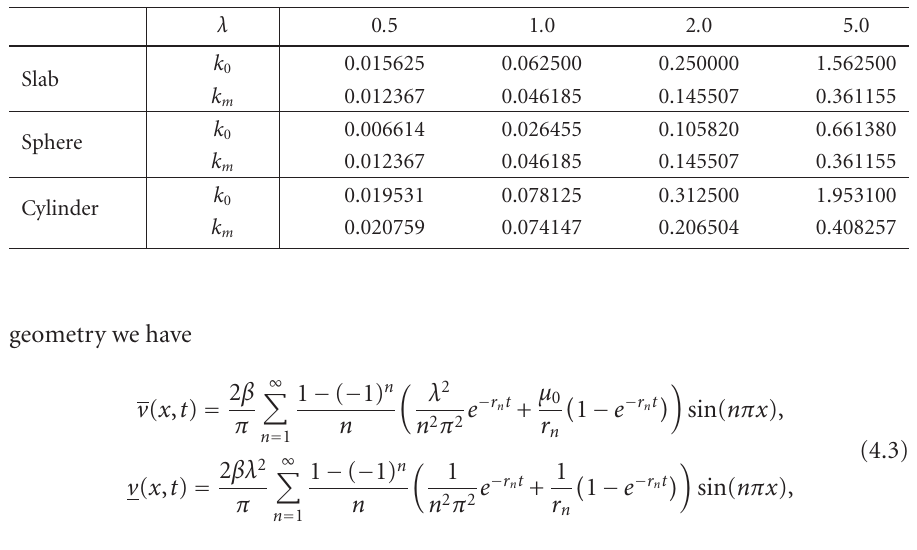
Table 4.1. The values of k 0 and k m , for β = 0 . 5 and δ = 0 . 1, in the three